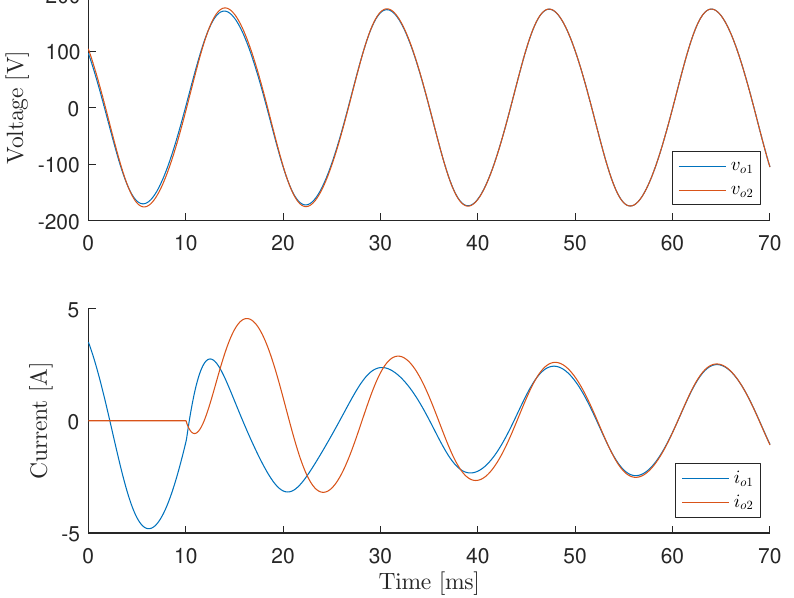
Figure 6. Synchronization of two oscillators designed with RM without